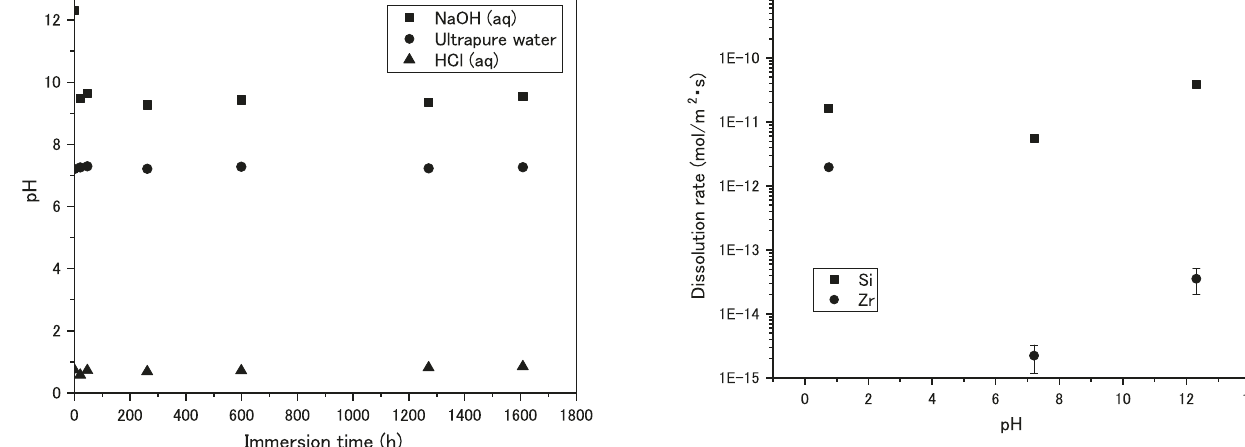
Fig. 3 The dissolution rates of Si and Zr evaluated from the temporal concentration changes in Si and Zr in each solution at the beginning of the immersion. Error bars represent the standard